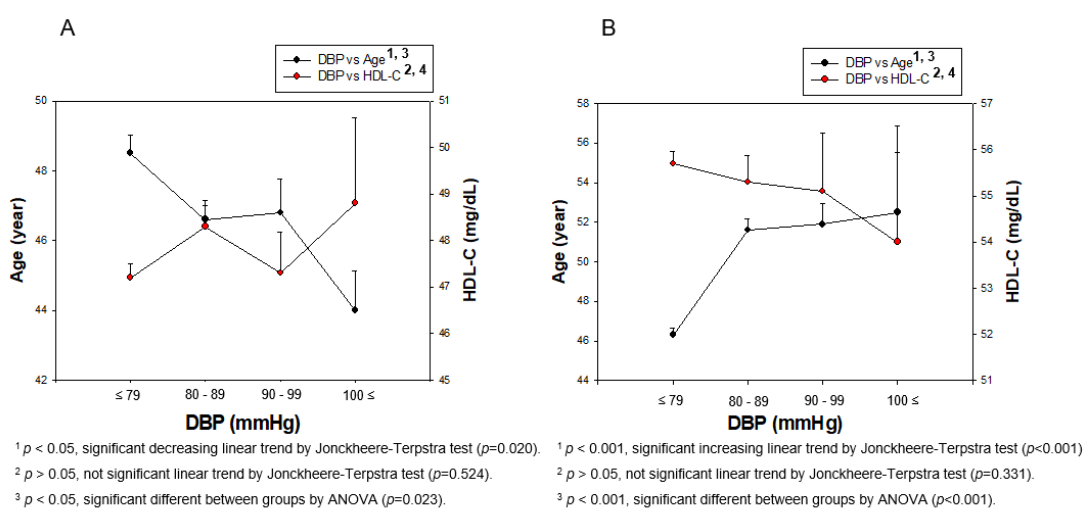
Figure 4. Pearson’s correlation analysis was carried out among age, HDL-C, and DBP in men ( A ) and women ( B ). The men ( A ) showed r = − 0.079 ( p = 0.0004) and women ( B ) showed r = 0.167 ( p < 0.001) between DBP and age. However, men ( A ) showed r = 0.026 ( p = 0.248) and women ( B ) showed r = –0.024 ( p = 0.221) between DBP and HDL-C.